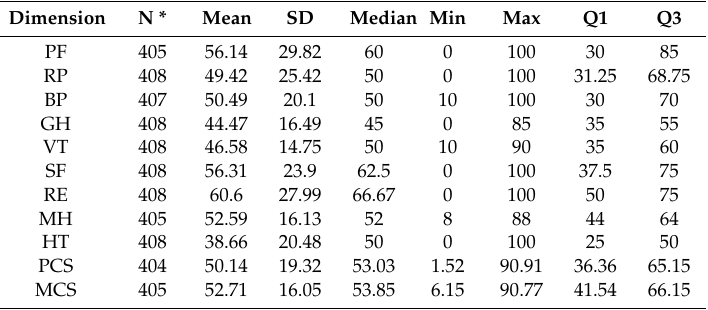
Table 3. Quality of respondents’ life in individual dimensions.